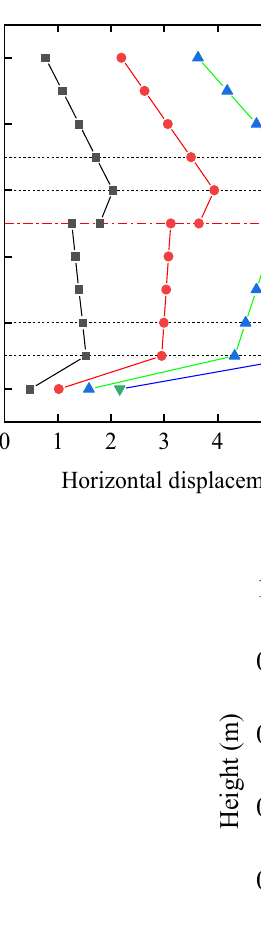
Figure 5: Earth stress box burial and strain gauge sticking.